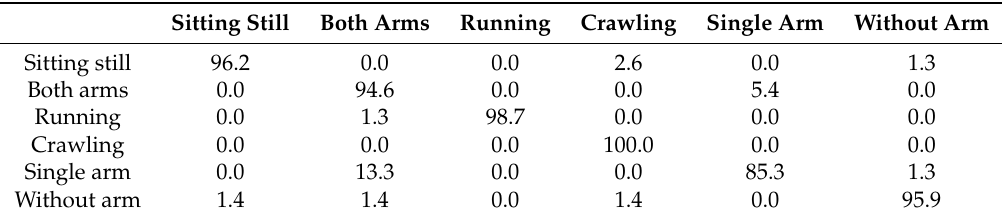
Table 5. Confusion matrix results of interference free